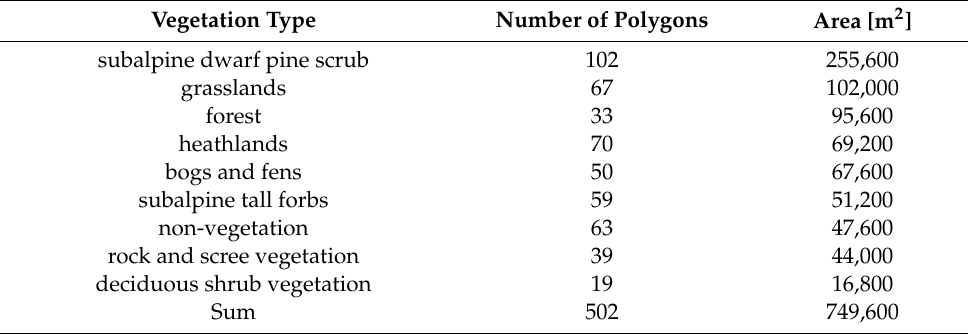
Table 2. The number of polygons representing vegetation